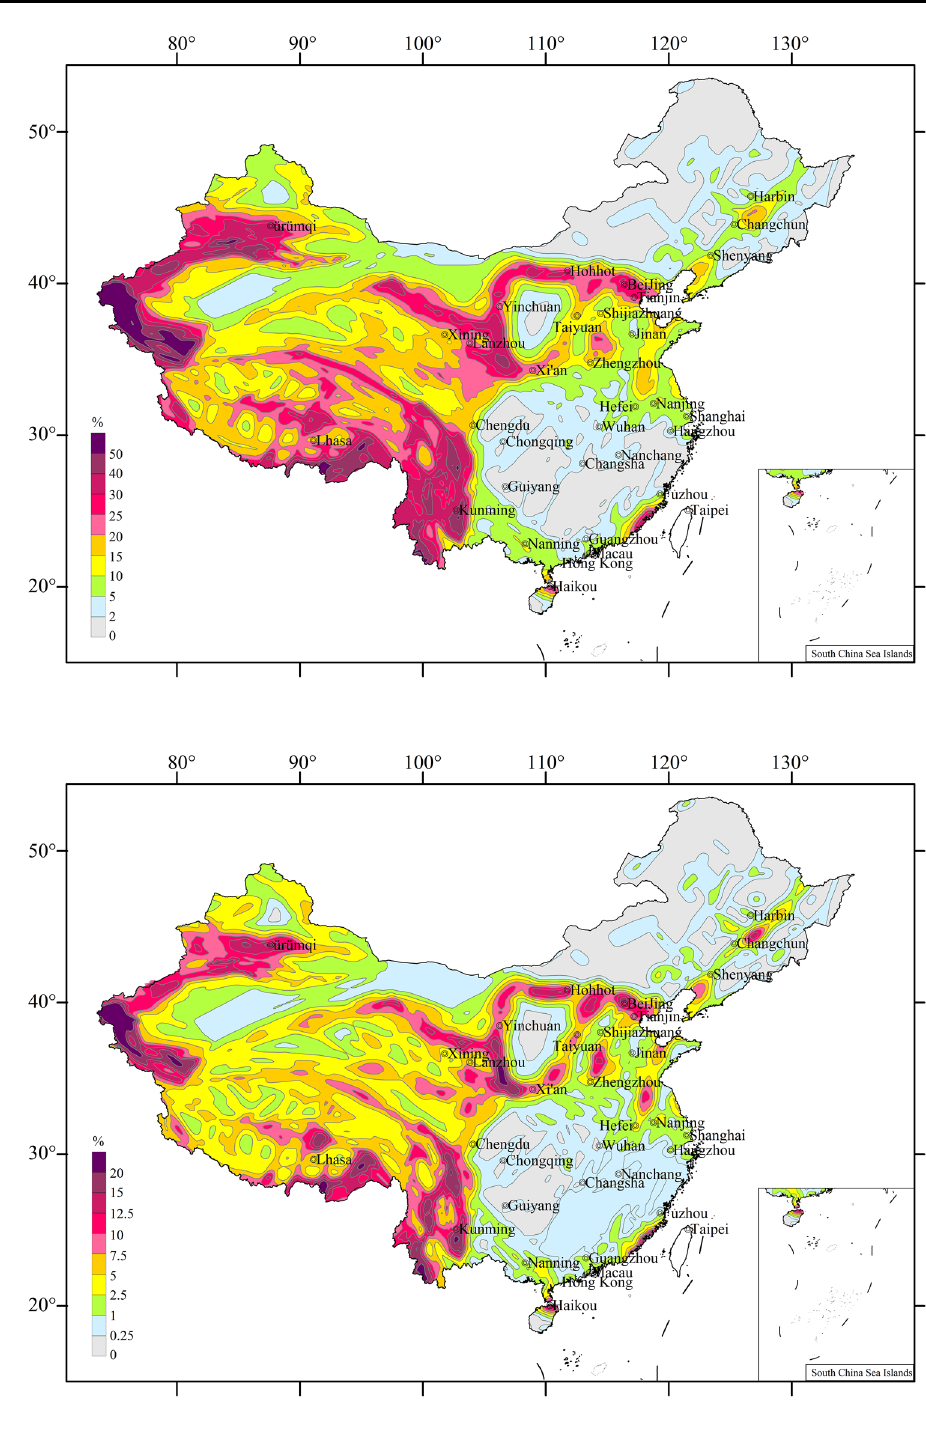
Fig. 9 Spatial distribution of the probability of the modified Mercalli intensity (MMI) VI earthquakes for China’s main- land in 2021–2030